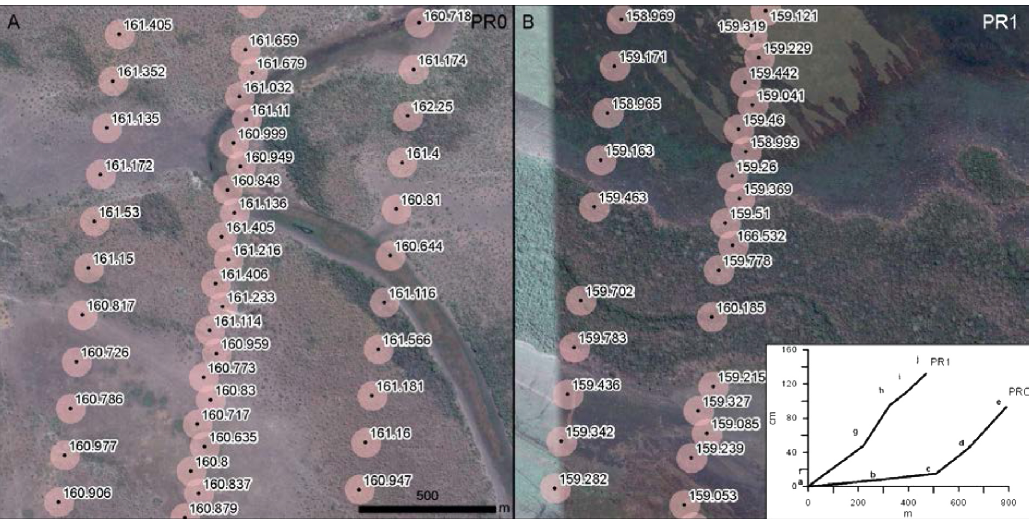
Figure 4. Elevation on the terrain as measured by ICESat across PR0 levee (a) and PR1 (b) . Pink circles represent the footprint of the laser pulse; the number is the elevation above the sea level as measured by the first peak in the received signal, thus indicating the elevation of the lowest reflecting surface within the footprint. In the inset the two topographic profiles along the studied catenas measured with a digital level.